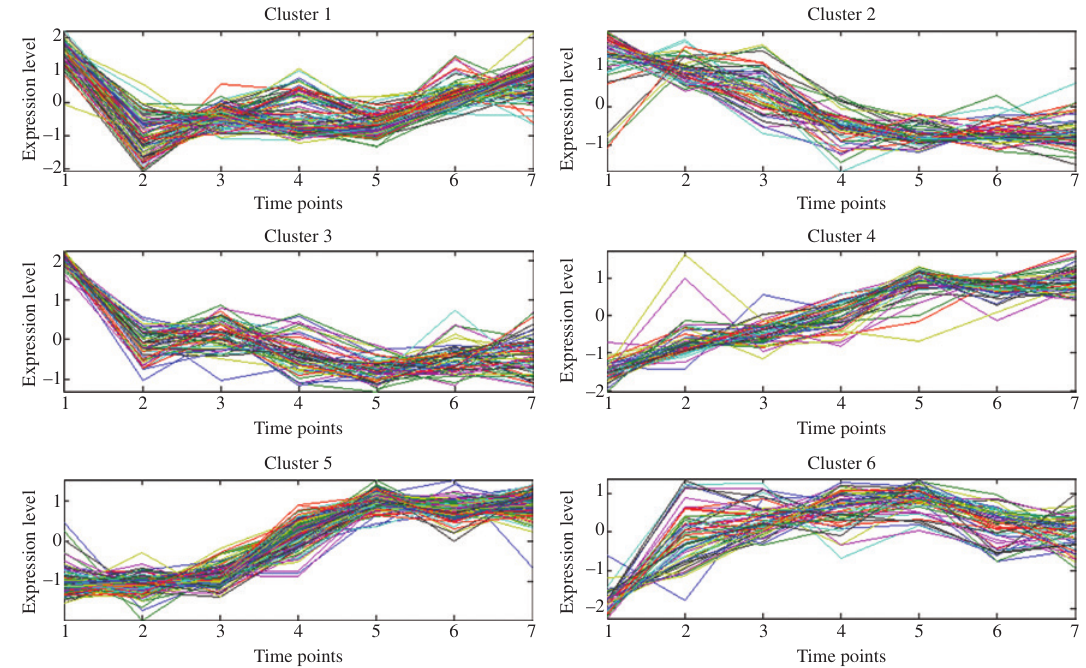
Figure 3: Cluster Profile Plots of Yeast Sporulation Data Clustered Using GWAC.